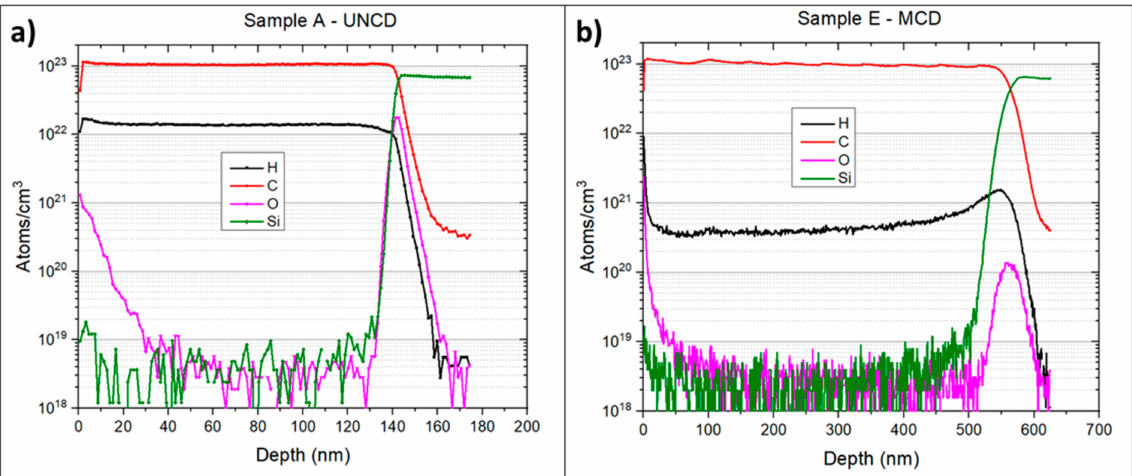
Figure 4. Spectra from SIMS analysis for PCD films with different grain sizes (A and E) show the C and H element distribution and content through the depth of the PCD films. The O and Si atoms from the SiO 2 layer on the Si substrate are present at the substrate–film interface. ( a ) Sample A, UNCD, ( b ) Sample E, MCD.